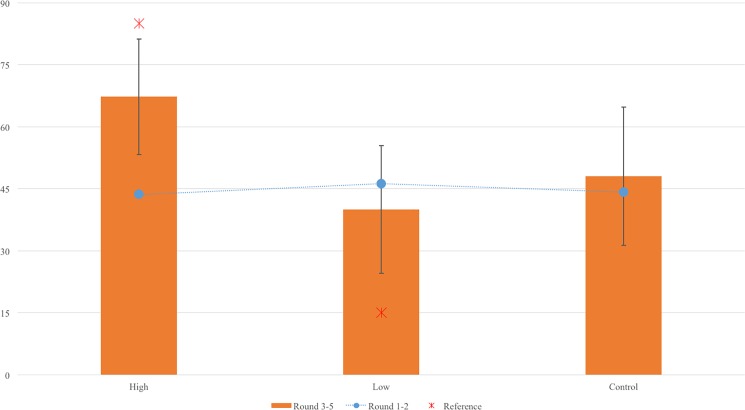
Means of token-sent under 3 conditions comparison of Round 3–5 with Rounds 1 and 2.